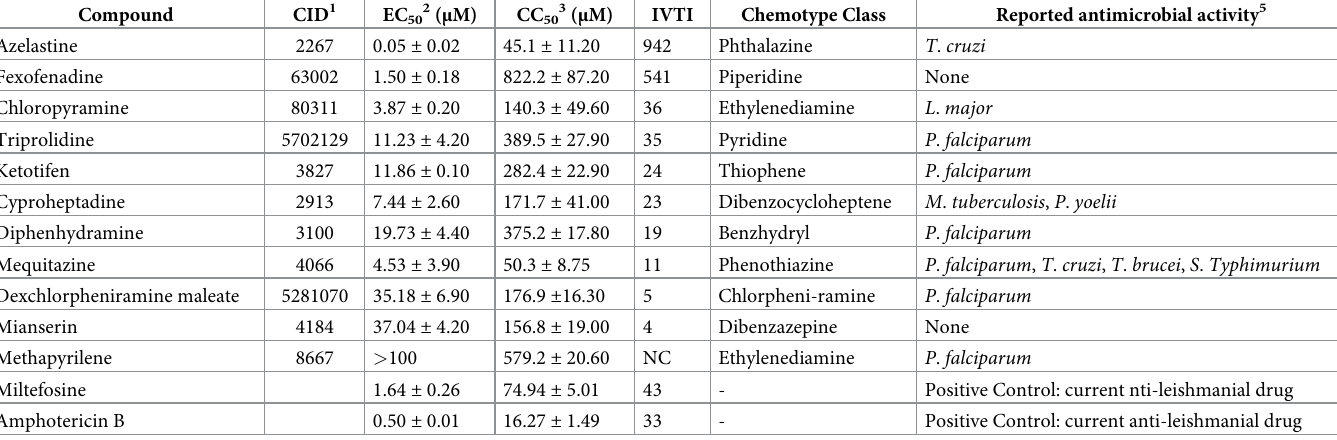
Table 1. In vitro therapeutic index of chemically diverse histamine H1 receptor antagonists (H1RAs) determined in the ex vivo lymph node explant system of L . major for anti-leishmanial activity and HepG2 cells for